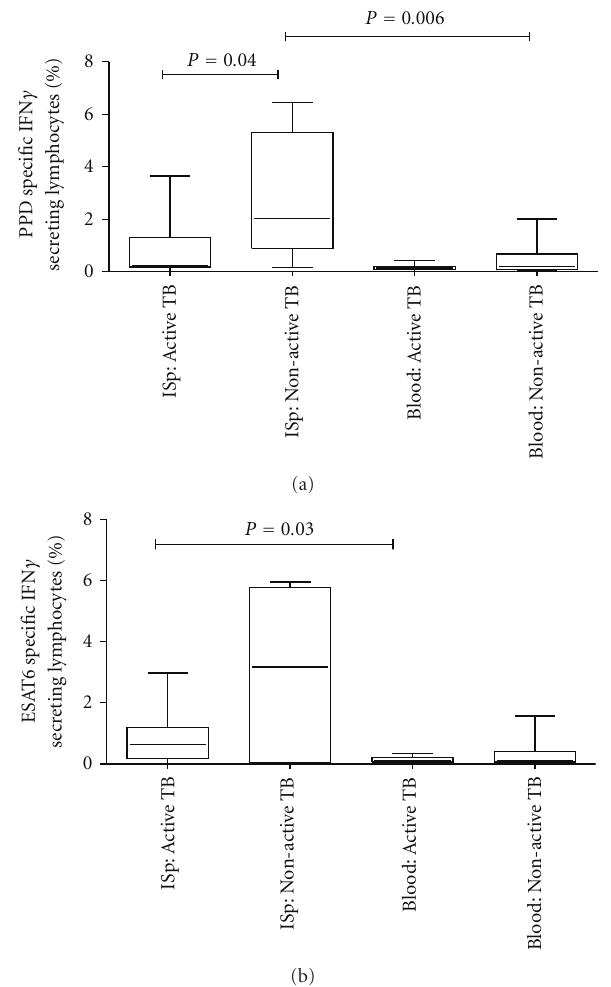
Figure 4: PPD (a) and ESAT6 (b) specific IFN γ secreting lympho- cytes in blood and sputum of patients with active and non-active TB. Sputum PPD-specific lymphocytes were significantly lower in the active TB group compared to the non-active TB group ( n = 19). M. tuberculosis antigen-specific lymphocytes were more frequent in sputum compared to